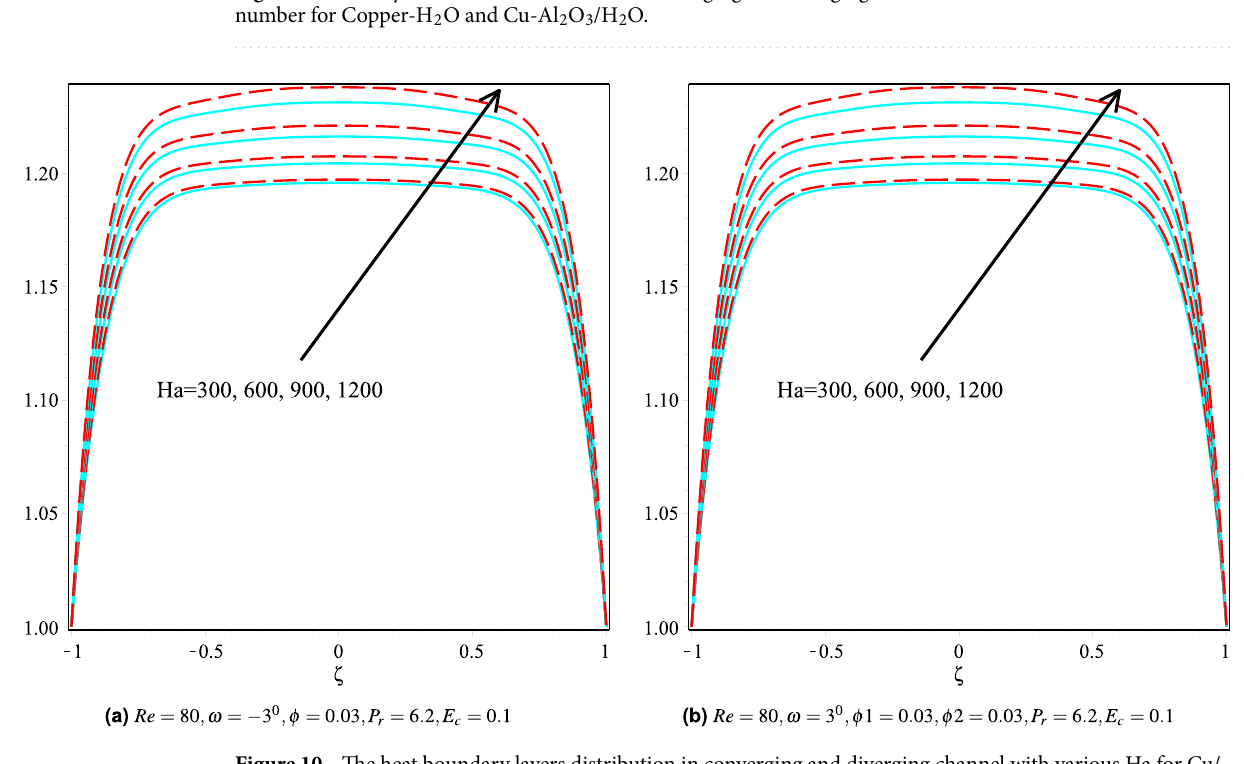
Figure 10. The heat boundary layers distribution in converging and diverging channel with various Ha for Cu/ H 2 O and Cu-Al 2 O 3 /H 2